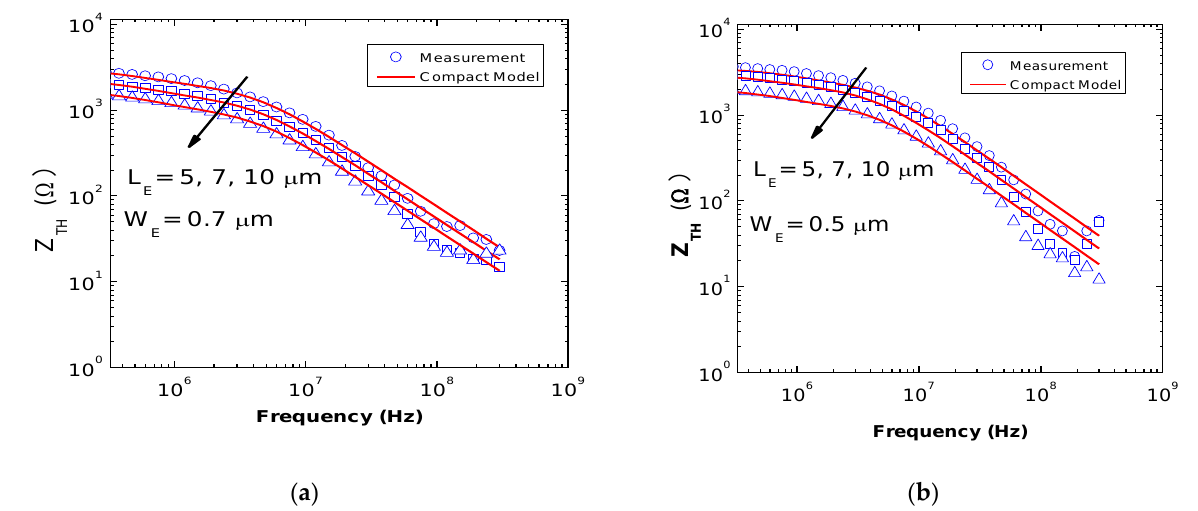
Figure 11. Magnitudes of the thermal impedance, Z TH , for two emitter width W E = 0.7 µ m ( a ) and 0.5 µ m ( b ). Table 1. Thermal resistance and capacitance contributions from the different epitaxial layers of the DHBT.